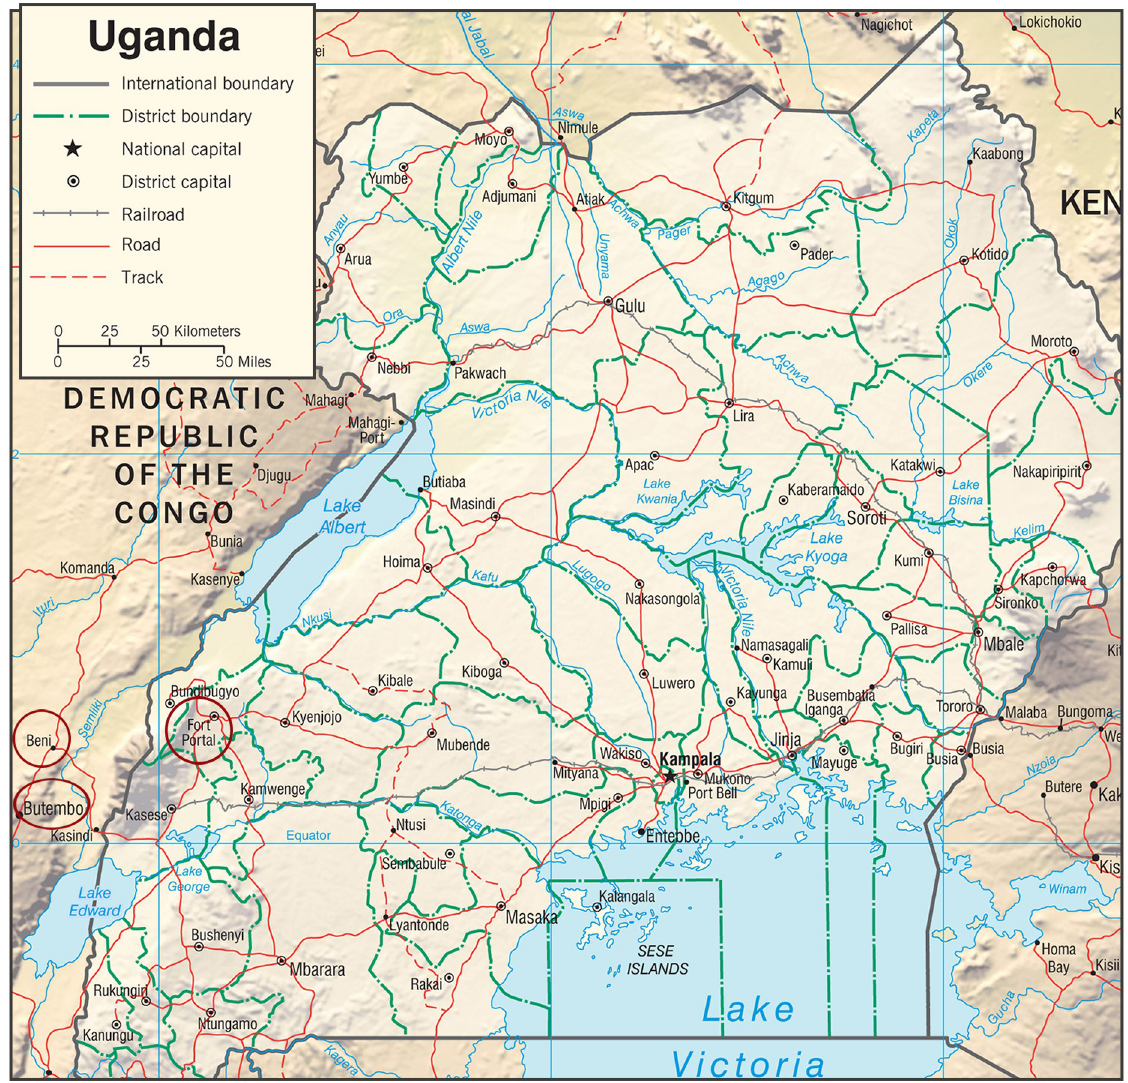
Fig 1. Map of Uganda and the bordering area of the DRC. Fort Portal, the JMEDICC hub site in Uganda, is located in the western part of Uganda near the border with the DRC and is circled in red; Beni and Butembo in DRC, sites of the 2018–present DRC Ebola virus outbreak, also shown and circled in red. Map taken from the CIA website the Uganda Physiography map https://www.cia.gov/library/publications/ resources/cia-maps-publications/Uganda.html. CIA, Central Intelligence Agency; DRC, Democratic Republic of Congo; JMEDICC, Joint Mobile Emerging Disease Intervention Clinical